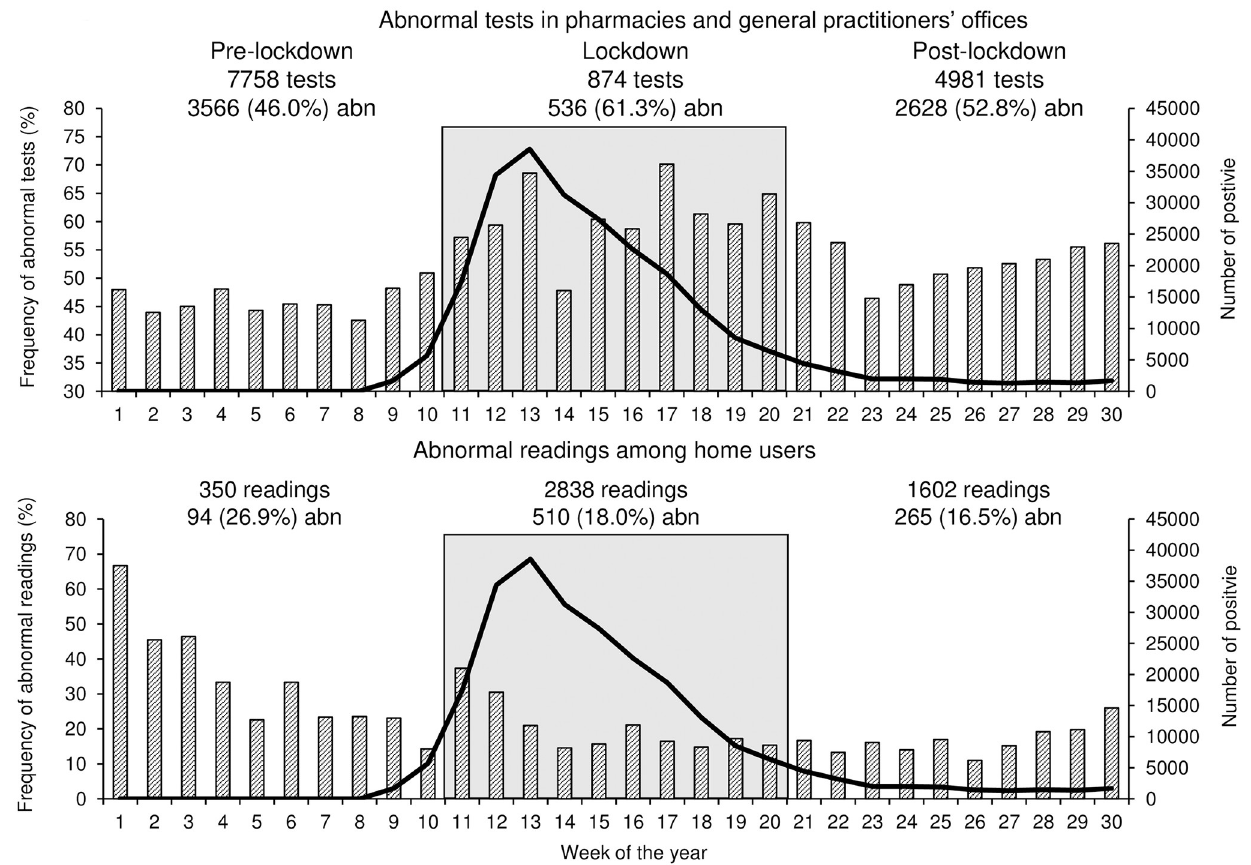
Fig 2. Weekly frequency (%) of abnormal tests in pharmacies and general practitioners’ offices or abnormal readings collected at home (striped bars). The thick continuous line represents the number of positive to SARS-CoV-2 tests. Pre-lockdown, lockdown, and post-lockdown periods are also